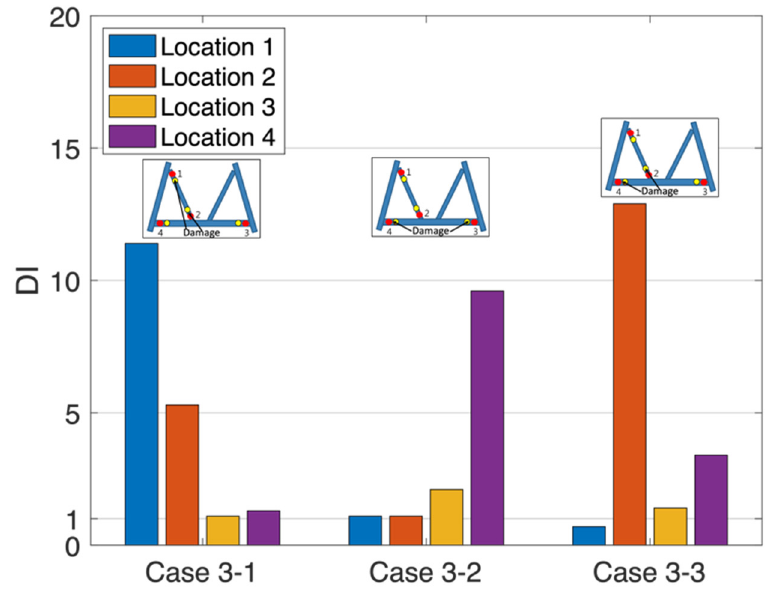
Figure 6. Damage of di ff ering severity in multiple locations.